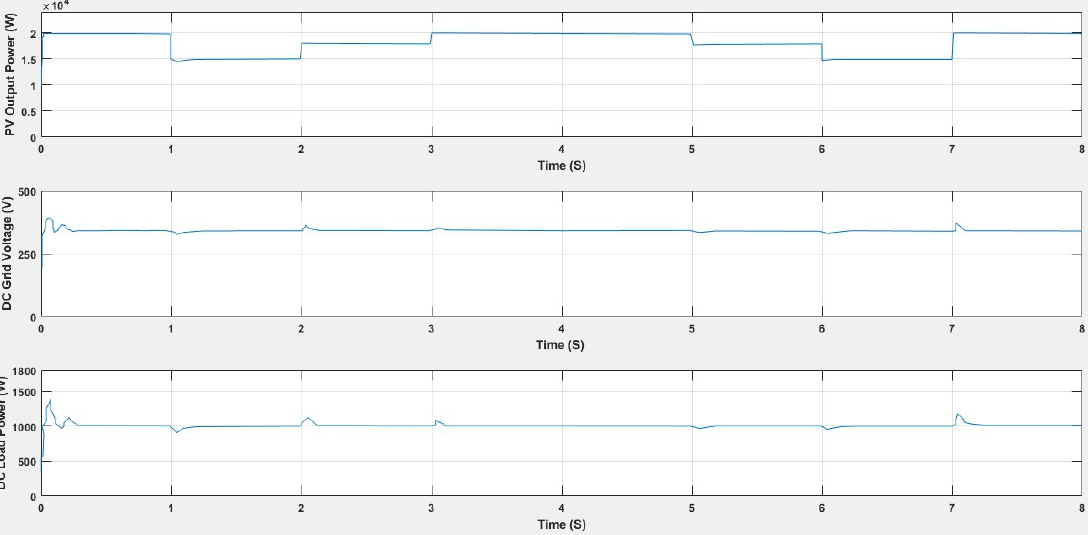
Figure 27. Testing Results samples for the PV output power, voltage and DC load power.